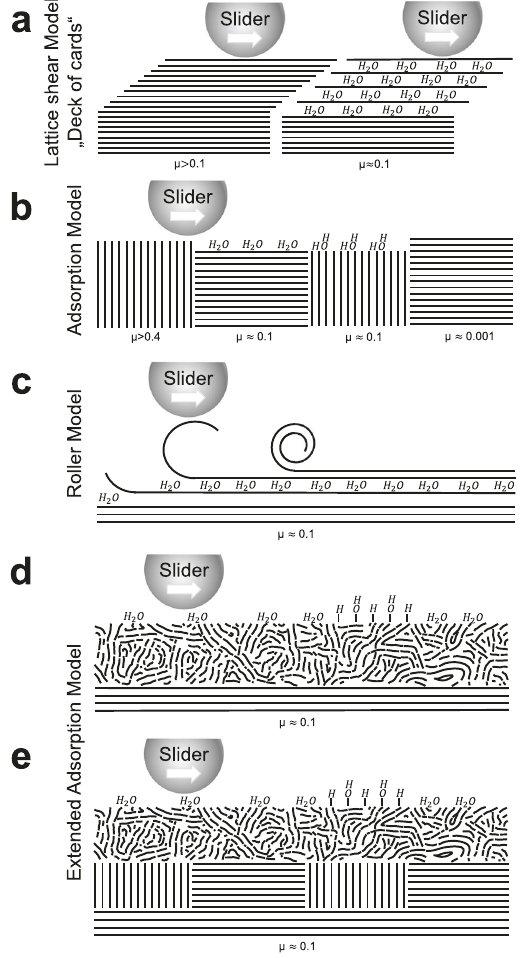
Fig. 1 | Schematic representation of the different models for solid lubrication by graphite. a Lattice-shear model: dry (left) and with water intercalation (right). b Adsorption model. c Roller model. d , e Adsorption model for graphite extended by shear-induced formation of turbostratic carbon for d high loads ( ≈ 1000MPa) and e lowloads(<100MPa).Typicalcoef fi cientsoffriction μ valuesaregivenunder the respective schematic